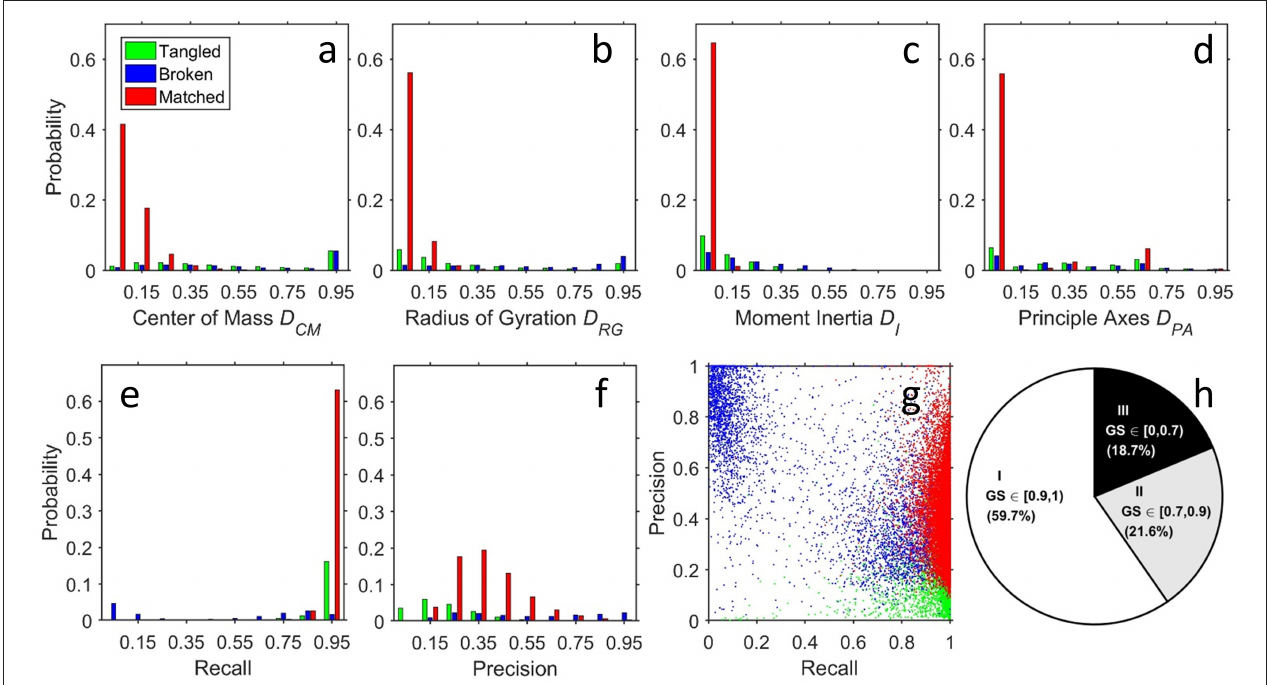
FIGURE 4 | Structural and voxel-to-voxel comparison between NR and human segmentation. Compared with human segmentation results, assessment of NR results is classified into three types: matched (M, red), broken (B, blue), and tangled (T, green) by visual validation of experts. The distributions of quantitative analyses were (a) the distance between centers of mass (position), (b) difference in the radii of gyration (size), (c) difference in moments of inertia (shape), (d) difference in orientation of the three principle axes of rotation (orientation), (e) recall, and (f) precision. (g) Scatter plot for the (recall, precision) for each neuron. The point (recall, precision) = (1, 1) implies a perfect match (identical NR- and human- segmentations). As expected, type M neurons (red points) had a recall since they successfully reproduced human segmentation. They also had an intermediate precision because of the greater thickness of the fibers and the preserved weaker fibers, as discussed in Figures 3A,B . The precision could be smaller than 0.5 due to the large surface-volume ratio of the fractal-like neuronal morphology. The tangled type T (green points) has high recall because the voxels in the NR result contained the whole target and low precision small because the neuron mixed with other neuron(s). Finally, the points for the broken type B form two groups. The first group is close to the group of red points (matched) but with lower recall, corresponding to the cases that only a few branches are missing. Another group is located at the upper left corner (low recall and high precision), corresponding to the cases that NR gets only the part close to the soma and misses most of the branches. (h) Pie chart for the ratios of the three classes according to the ranges of the